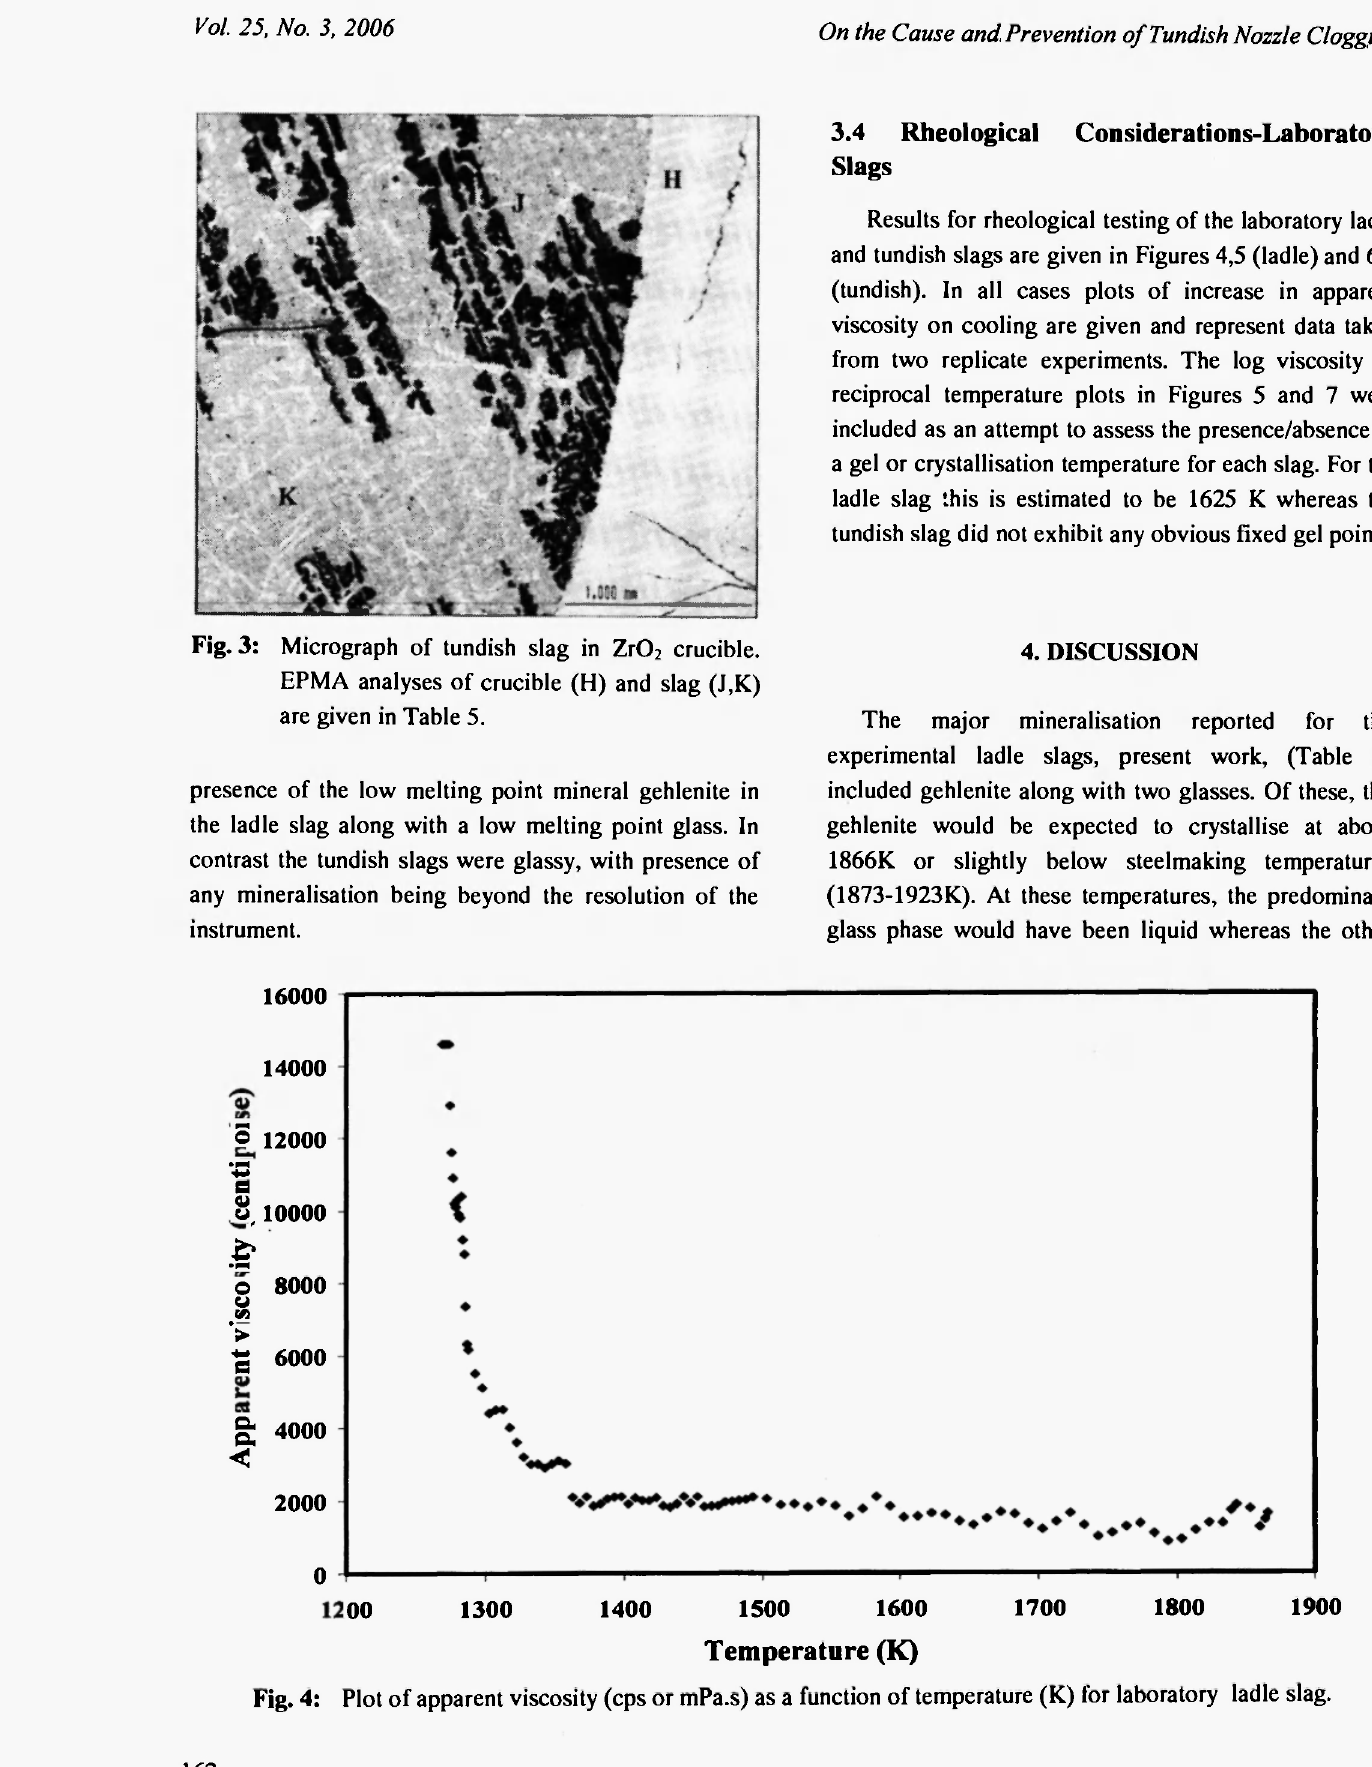
Plot of apparent viscosity (cps or mPa.s) as a function of temperature (K) for laboratory ladle